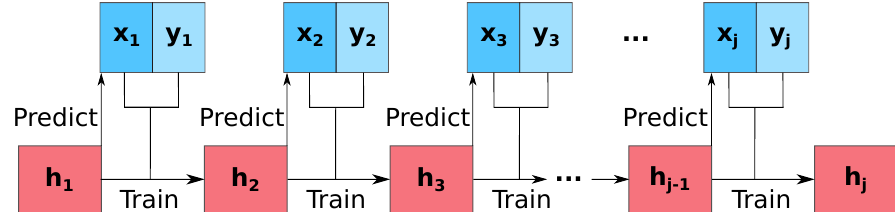
Figure 3. Stream learning (online learning) scheme with test-then-train